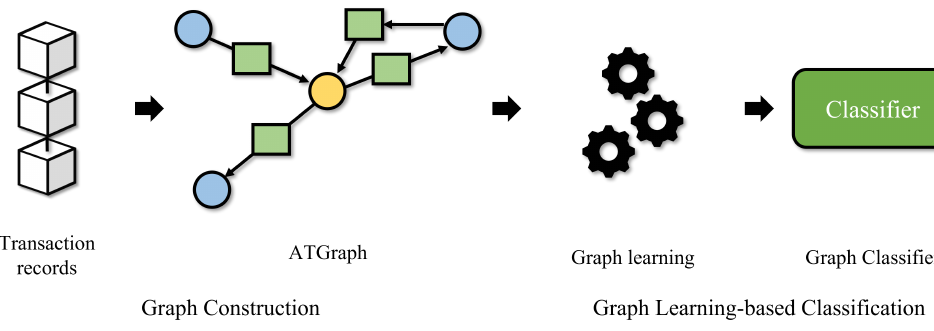
Figure 1. Overview of the proposed Ethereum phishing account detection framework.